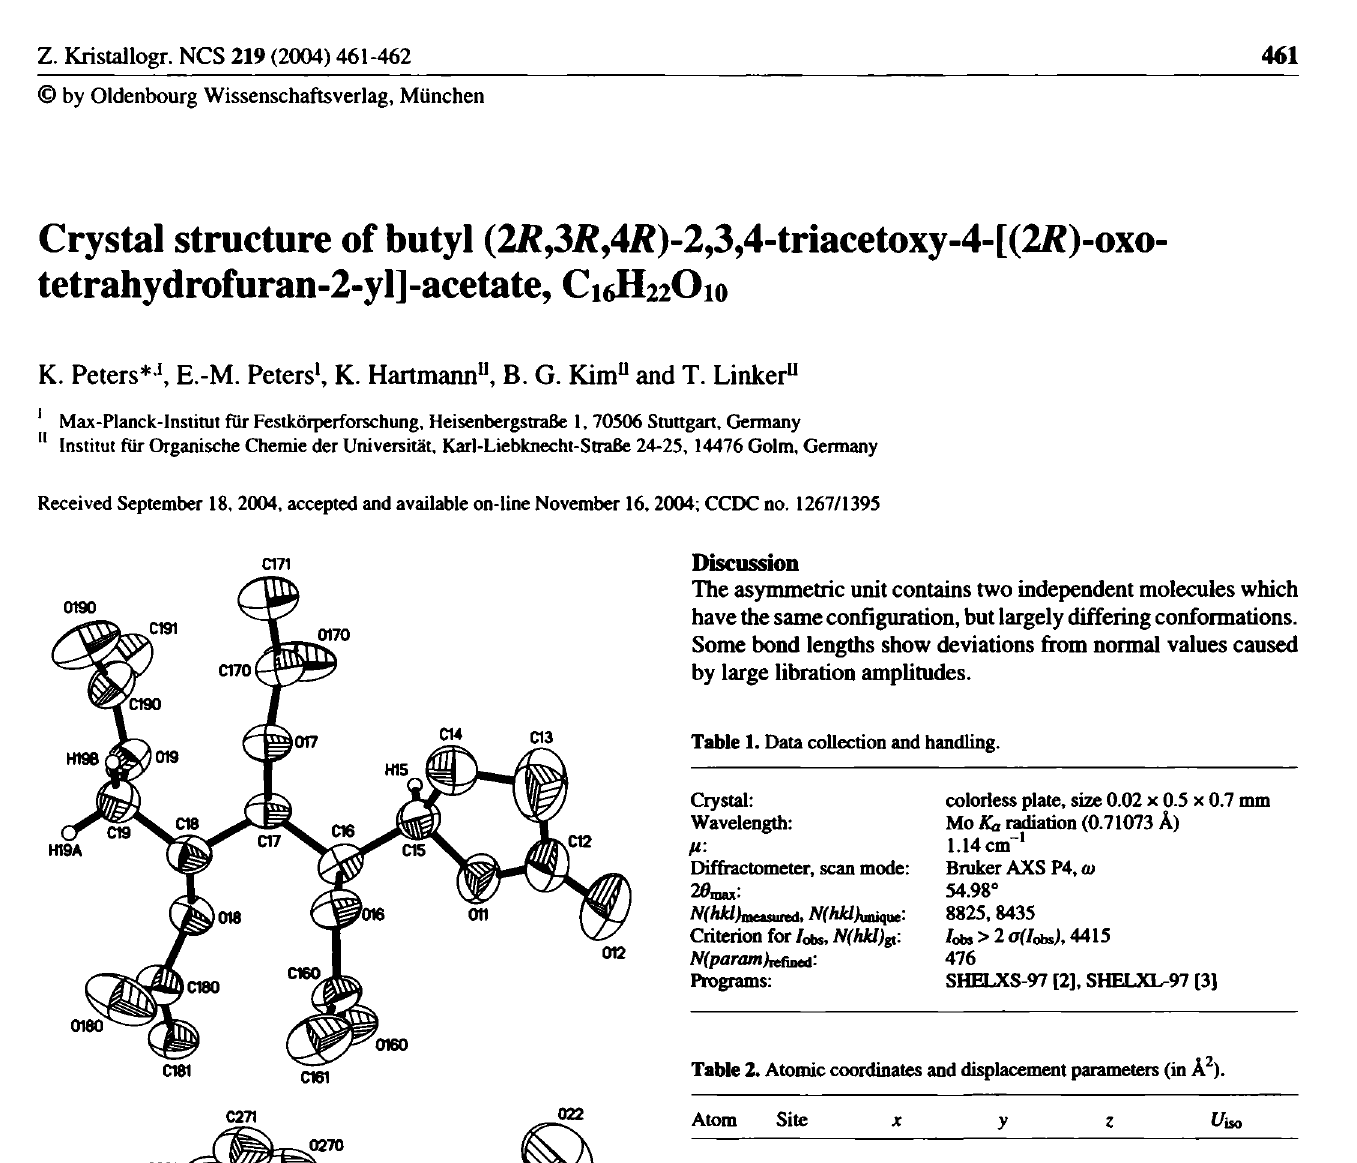
Table 2. Atomic coordinates and displacement parameters (in Â 2